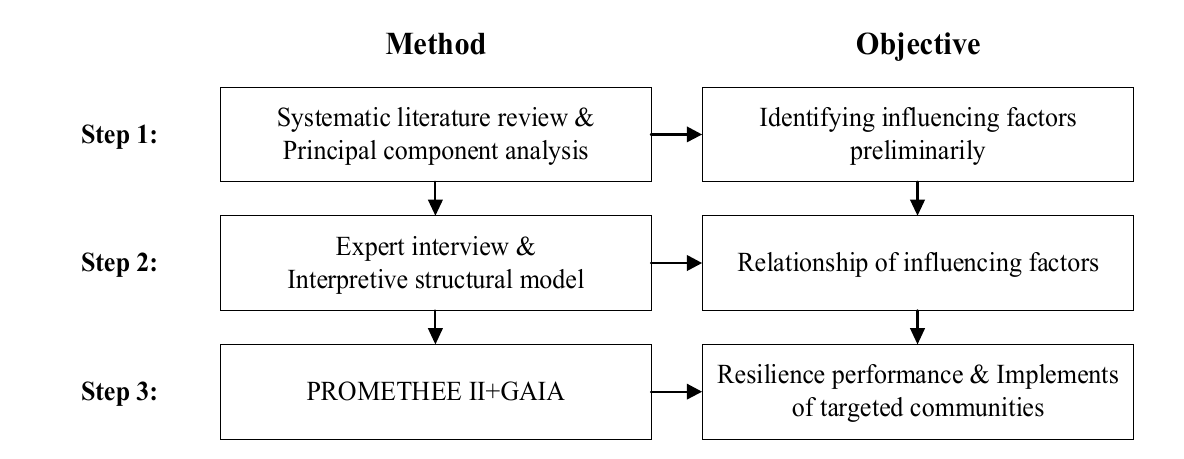
Figure 1. The organization of this study.